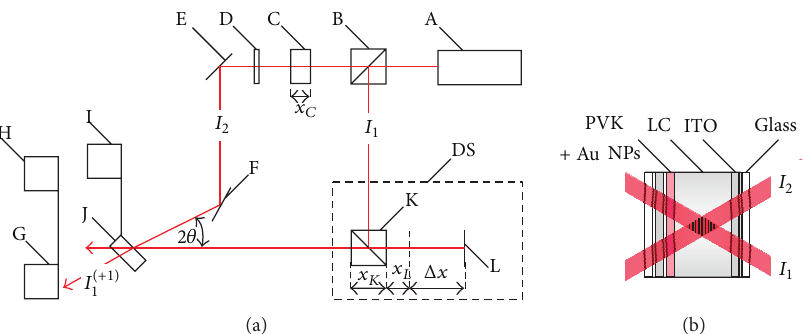
Figure 1: Scheme of the coherence meter prototype (a) and spatial light modulator (b). A: tested laser, B, K: beamsplitter, C: phase compensator, D: filter, E, F: mirror, G: photodiode, H: voltmeter, I: DC voltage supplier, J: spatial light modulator, L: sliding mirror, and DS: delay system. DC = 20 V, 2𝜃 = 0.17